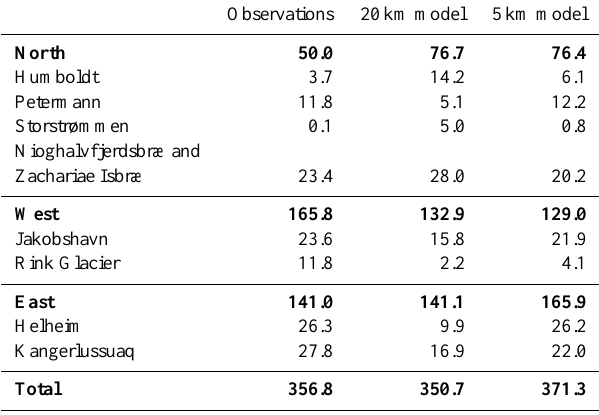
Table 2. Ice discharge prior to 2000 as inferred by Rignot and Kana- garatnam (2006) and as simulated with the ice sheet model using two resolutions. Observationally inferred values are representative of 1996 (or 2000) while simulated values are averaged over the period 1960–1990. These values therefore represent ice discharge prior to any major acceleration in the outlet glaciers. All values are given in km 3 yr − 1 (bold font indicates regional values).